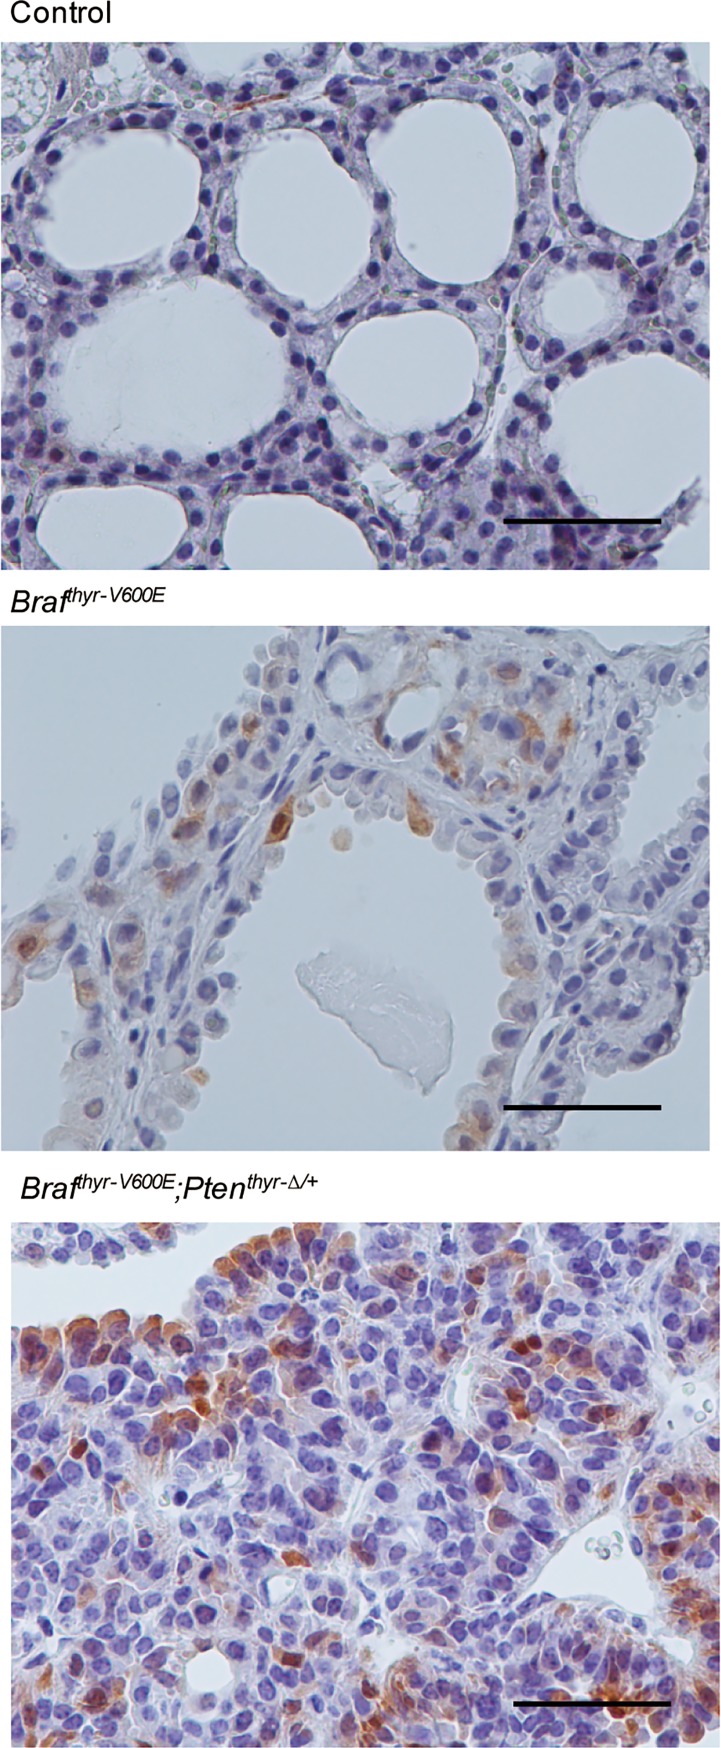
Phosphorylated ERK staining of the thyroid gland from control, and BrafCA/w and Brafthyr-V600E;Ptenthyr-Δ/+ mice.The thyroid gland from each mouse in Fig 2 was subjected to pERK staining as described in the Materials and Methods. Scale bars, 50 μm.